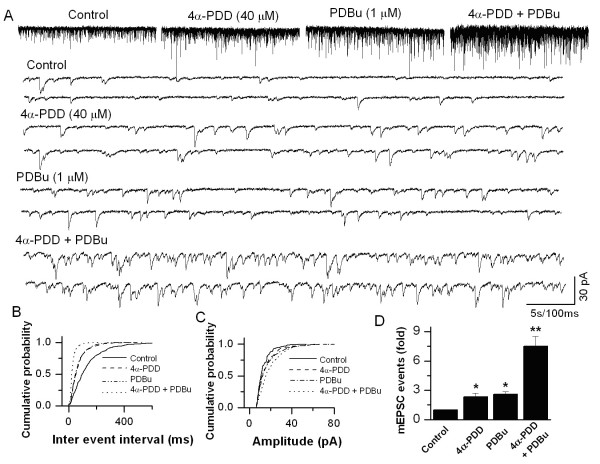
Potentiation of 4α-PDD-induced changes in synaptic transmission by PDBu in DRG-DH co-cultures. A. Application of 4α-PDD (40 μM) increases the frequency of mEPSCs and this action is enhanced by incubation with PDBu (1 μM). Synaptic currents are shown at a higher time resolution below. B. Cumulative probability plot indicates an increase in the frequency of synaptic events with 4α-PDD, which is further significantly enhanced following by PDBu incubation. C. The increase in frequency of events is not accompanied by a change in the amplitude. D. Summary graphs showing 4α-PDD-induced an increase in mEPSC frequency (n = 5) and potentiation by PDBu (n = 3). The asterisk (*) represents P < 0.05 as compared to control; (**) represents P < 0.05 as compared to 4α-PDD group.